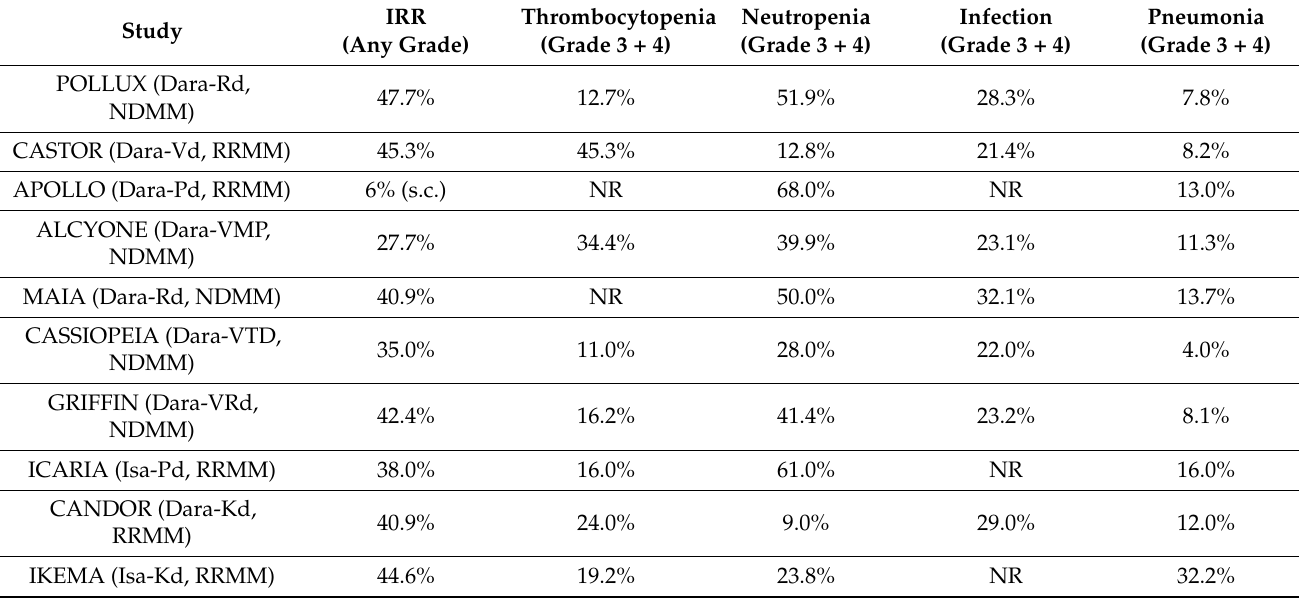
Table 5. The most common toxicities of anti-CD38 containing